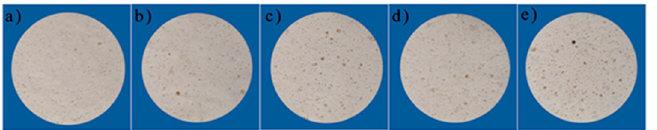
Figure 3. The first set of test samples. Pure petroleum-based polyurethane foam (PPUF) ( a ); TOPUF ( b ); TOPUF adding 10 mm ( c ), 7 mm ( d ), 4 mm ( e ) ML strips and ML powders ( f ).